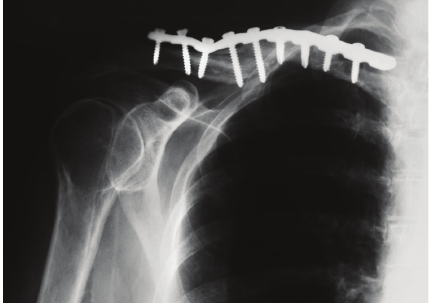
Figure 2: Radiograph of the right clavicle with fracture fixation plate and screws. The inferior prominence of the bone may have reaggravated the brachial plexus injury. Revision surgery was not